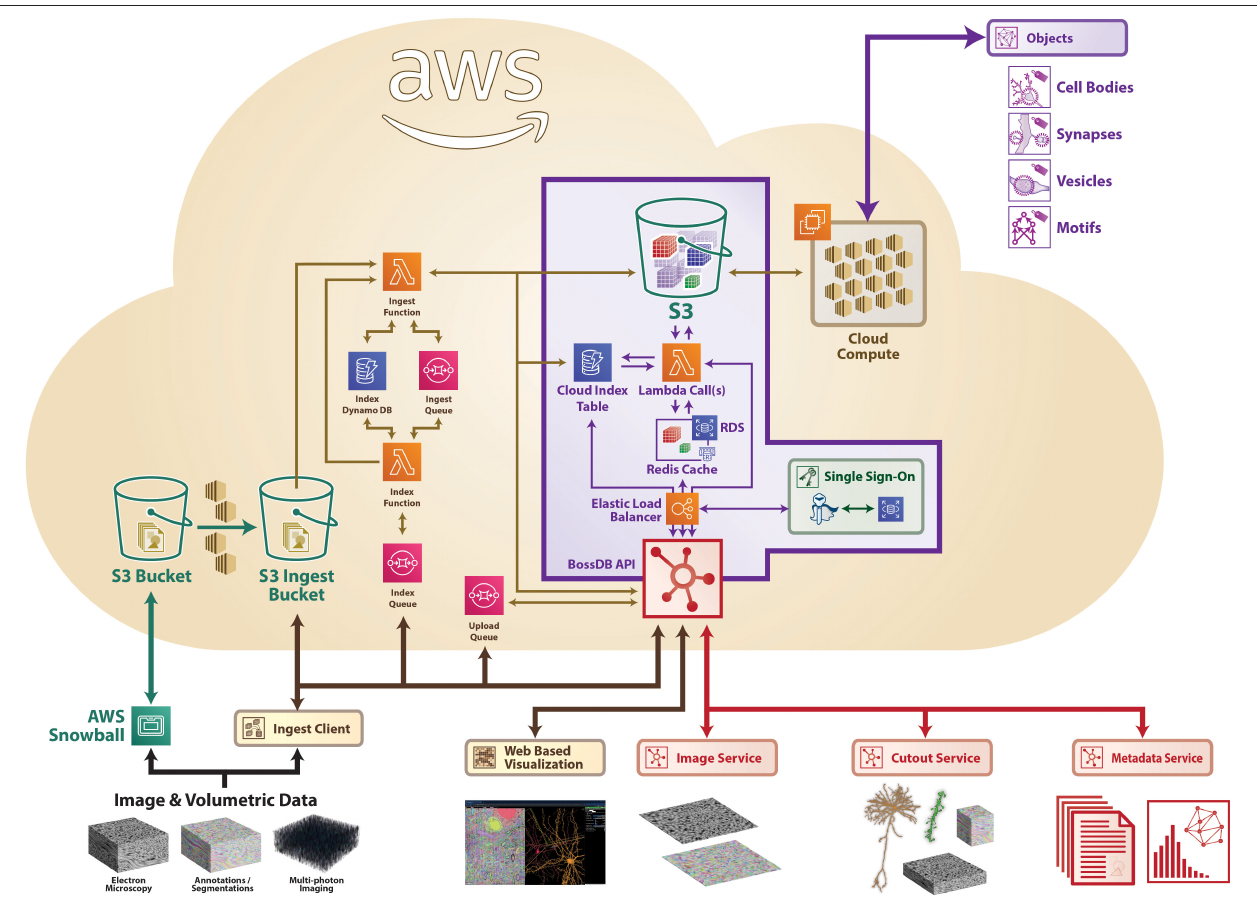
FIGURE 7 | A high-level architecture diagram of BossDB as deployed using Amazon Web Services architecture, highlighting a number of services, including ingest processes on the left. Sample data included for demonstration (see text footnote